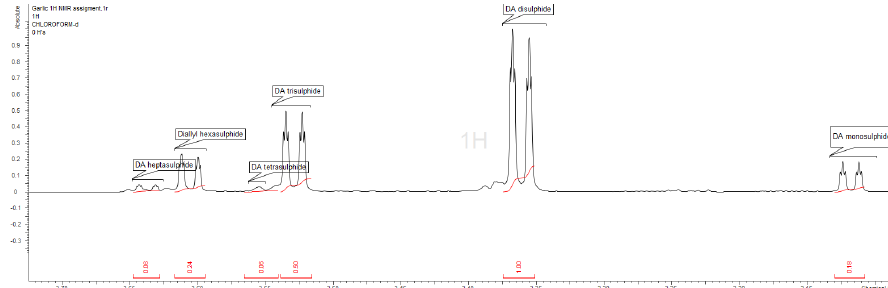
Figure 1. Garlic essential oil 1 H NMR spectrum.